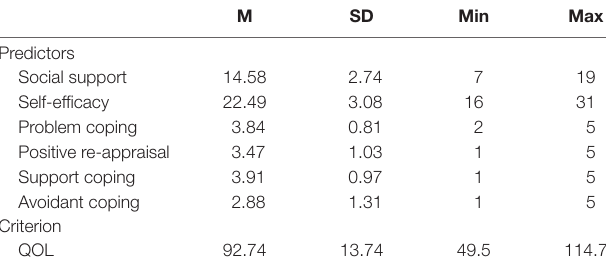
TaBle 2 | Means, SDs, minimum and maximum scores of the